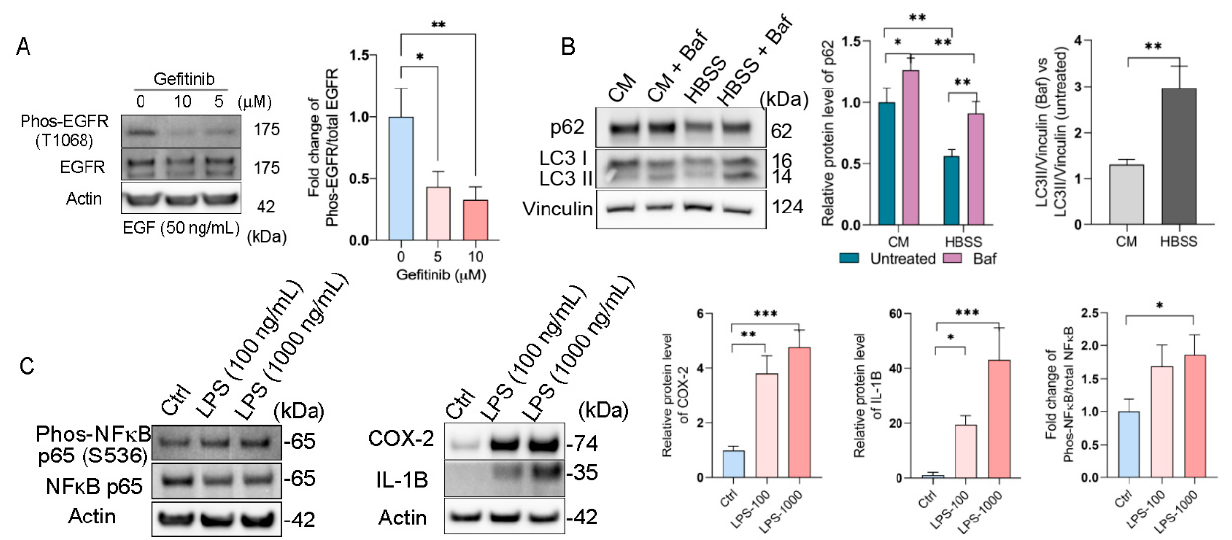
Figure 5. RPE flatmount culture is valid for downstream treatments. ( A ) RPE flatmounts obtained from 3-month-old C57BL/6J wild-type mice were starved in DMEM only medium and incubated with Gefitinib (EGFR inhibitor) for 3 h. RPE flatmounts were then stimulated with EGF for 30 min. Data showed the inhibition of EGFR activation by Gefitinib. ( B ) Autophagy flux measurements in RPE flatmounts with or without starvation. RPE flatmounts were obtained from 8-month-old C57BL/6J wild-type mice and cultured in complete medium for 16 h, and then either cultured in complete medium with Bafilomycin A1 or starved in HBSS with Bafilomycin A1 for 3 h. RPE flatmounts were then collected for western blotting analysis. The data showed an increase in LC3II accumulation (after the blockage of autolysosome formation by Bafilomycin A1) and a decrease in p62 expression in the starved RPE flatmounts, suggesting enhanced autophagy flux after starvation. ( C ) RPE flatmounts obtained from 8-month-old C57BL/6J wild-type mice and cultured in complete medium with or without different doses of LPS for 24 h were collected and analyzed for an inflammatory response. The COX-2, IL-1B, and phosphorylated NF- κ B protein levels were measured by western blotting and the data showed significant upregulation of the respective proteins in LPS-treated RPE flatmounts. Statistical analysis was performed using one-way ANOVA. * p < 0.05, ** p < 0.01, *** p < 0.001. n = 3.